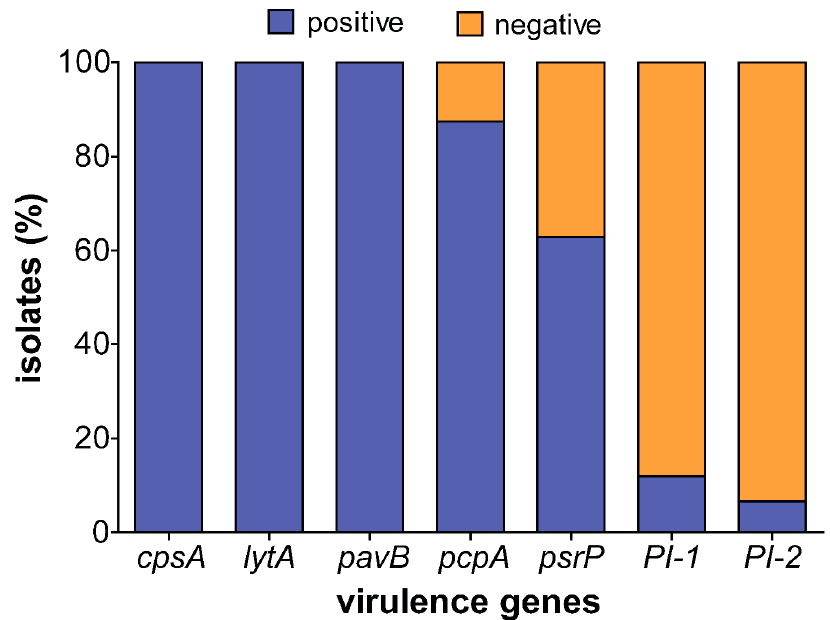
Figure 5. Prevalence of virulence genes among carriage isolates. More than half of the isolates tested positive for the pcpA and psrP genes while less than a quarter tested positive for the PI-1 and PI-2 . However, all the strains were positive for the core genome virulence genes including pavB and lytA.